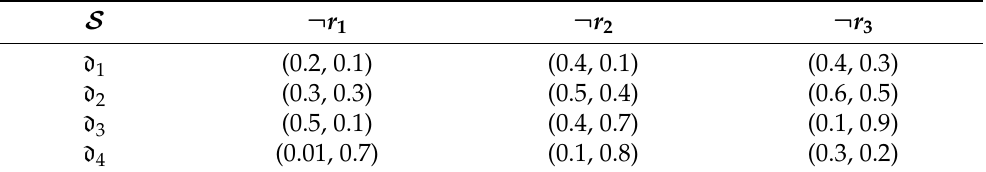
Table 3. Table for belongingness and non-belongingness values for the set ¬R